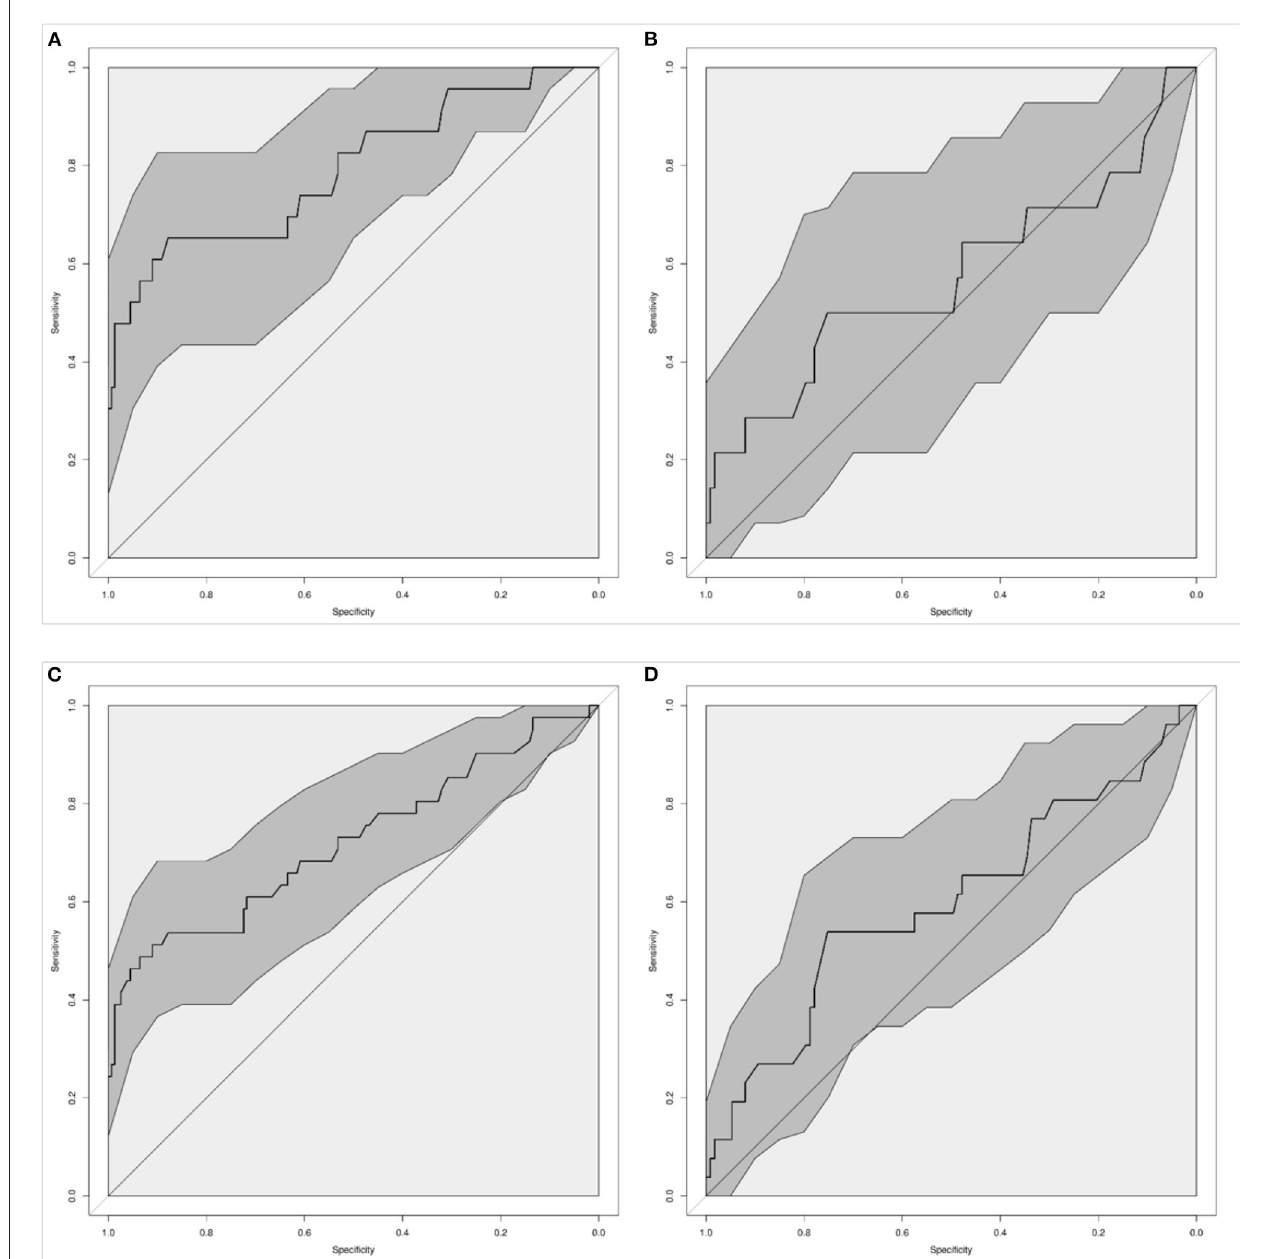
FIGURE 1 | Diagnostic accuracy of C-Reactive Protein [CRP; (A,C) ] and Procalcitonin [PCT; (B,D) ] to diagnose infection in neonates and children on ECMO. Graphs show the Receiver-Operating Characteristic Area Under the Curve (AUC) for confirmed infection (A,B) , and for confirmed and suspected infection (C,D) . Dark gray shaded areas indicate 95%-Confidence